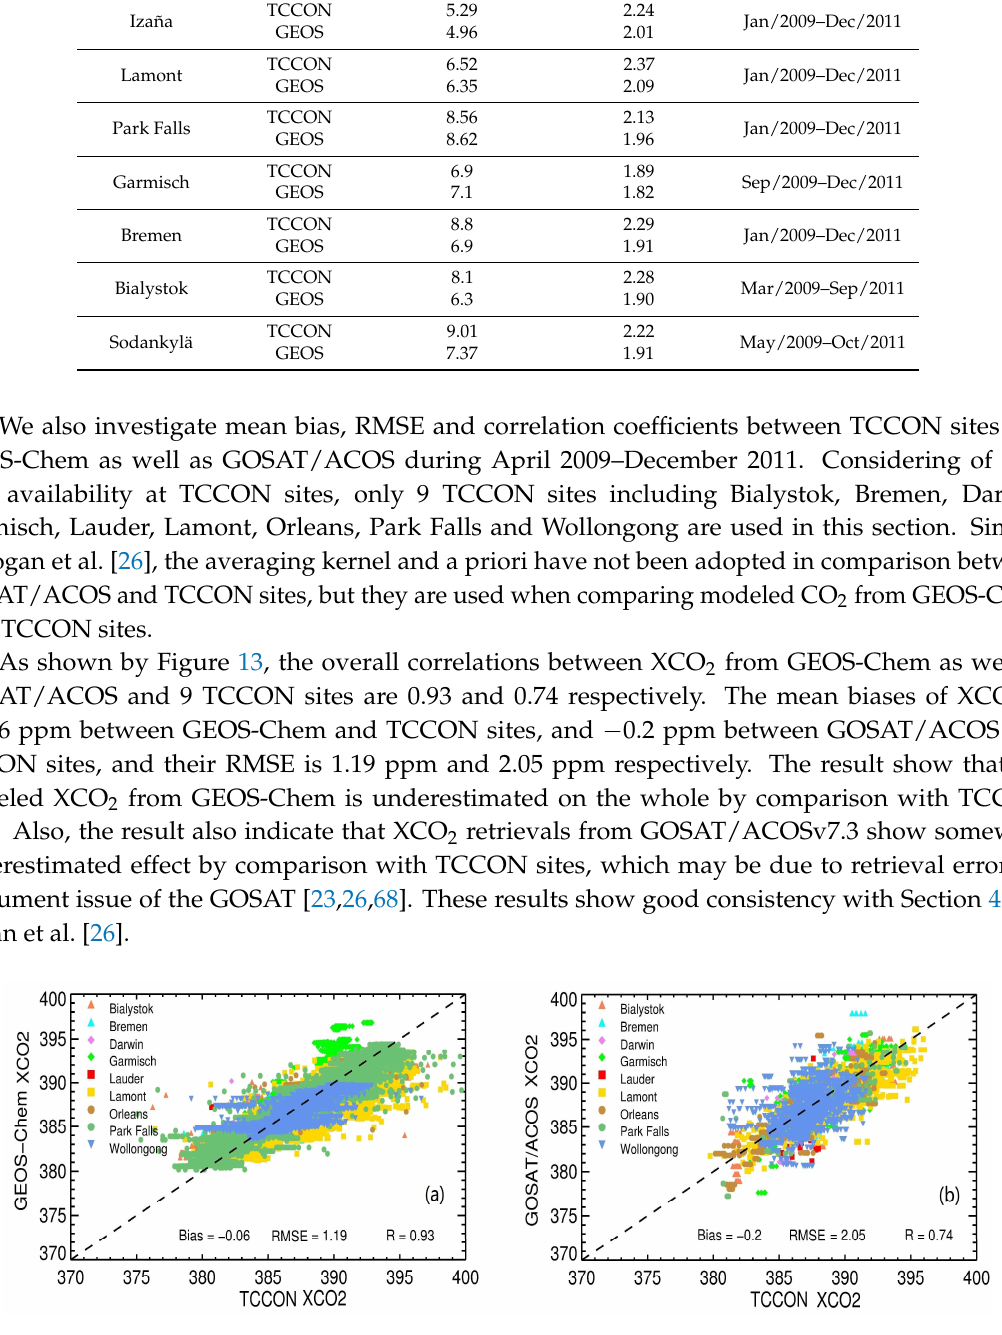
Figure 13. The scatter plot of XCO 2 between GEOS-Chem as well as GOSAT/ACOS and 9 TCCON sites during April 2009–December 2011. ( a ) The scatter plot between XCO 2 from GEOS-Chem and XCO 2 from TCCON sites; ( b ) The scatter plot between XCO 2 from GOSAT/ACOS and XCO 2 from TCCON sites.